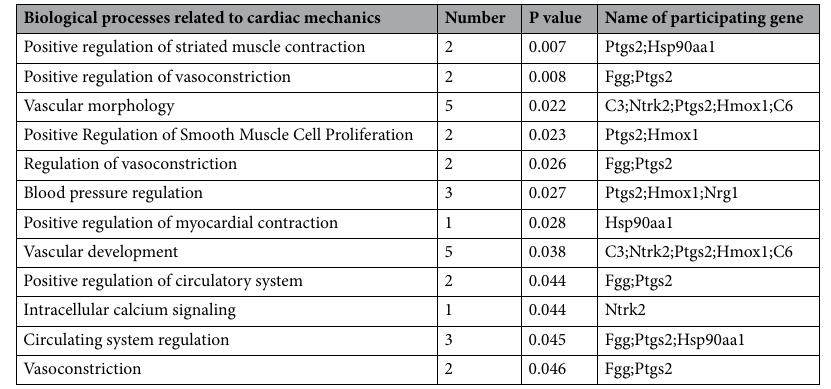
Table 1. Expression differences of genes related to cardiac mechanics in SHR group after amiodarone treatment and 12 biological processes related to cardiac